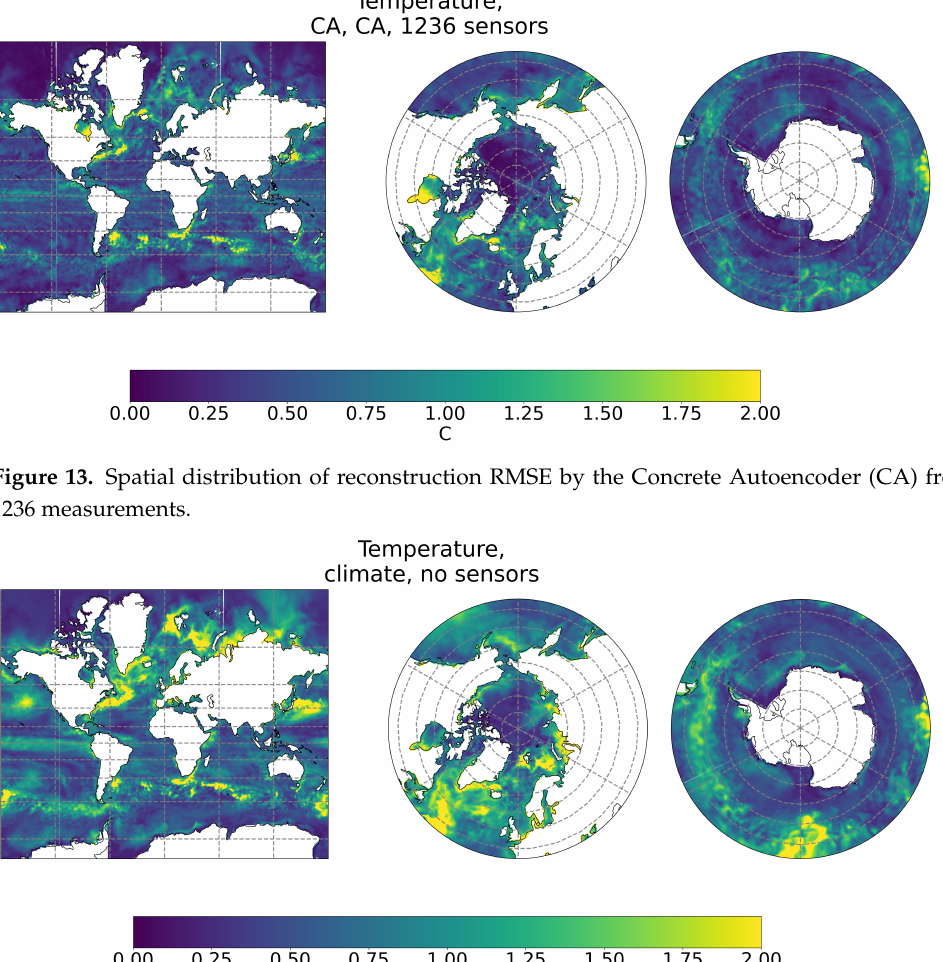
Figure 14. Spatial distribution of reconstruction RMSE by climate without